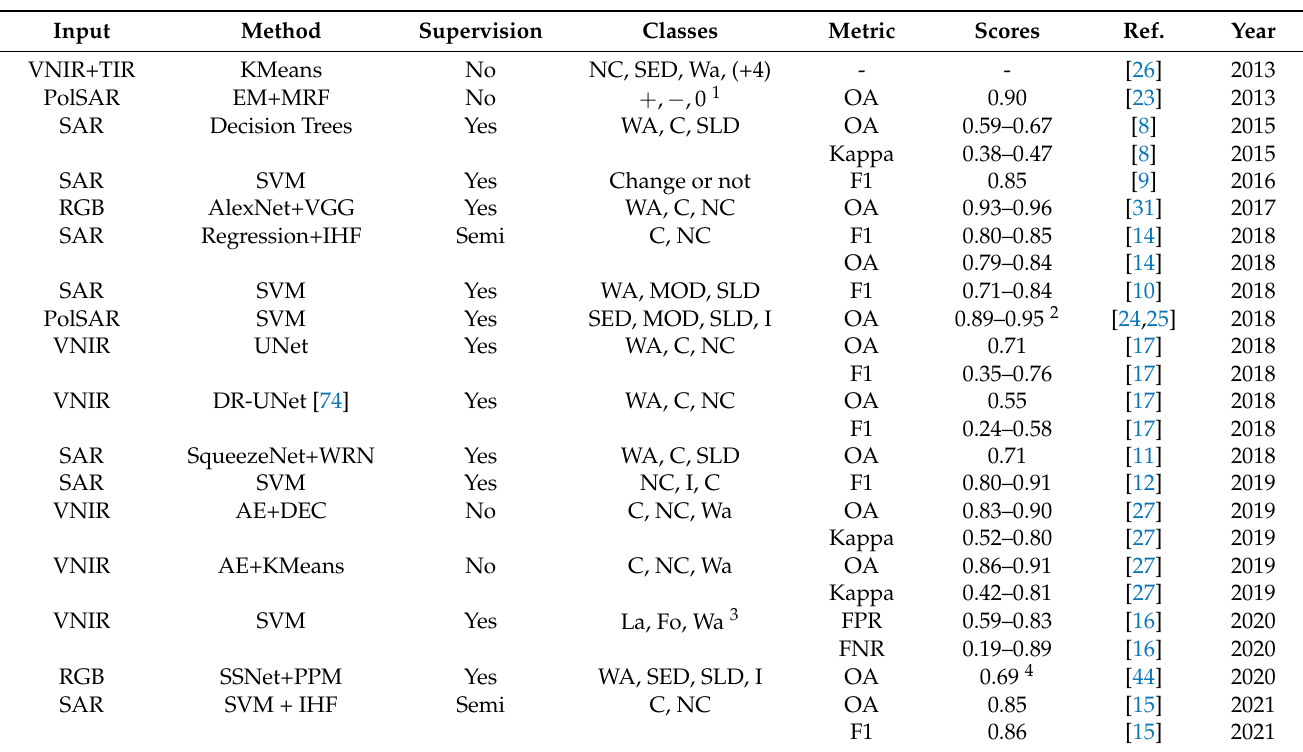
Table 3. Chronological results of the different AI methods applied to images of the Tohoku tsunami for damage assessment or identification. OA is for Overall Accuracy, F1 for the F1 score, FPR for false positive rate, and FNR for false negative rate. See Figure 5 for the detailed class names. 1 The authors only mention a positive-change class, a negative-change class, and a no-change class, without more details. 2 block approach results. 3 La is for land areas, Fo for foam and Wa for water, either the sea or flooded areas. 4 Ignoring the 98% accuracy to detect majority class of non-built